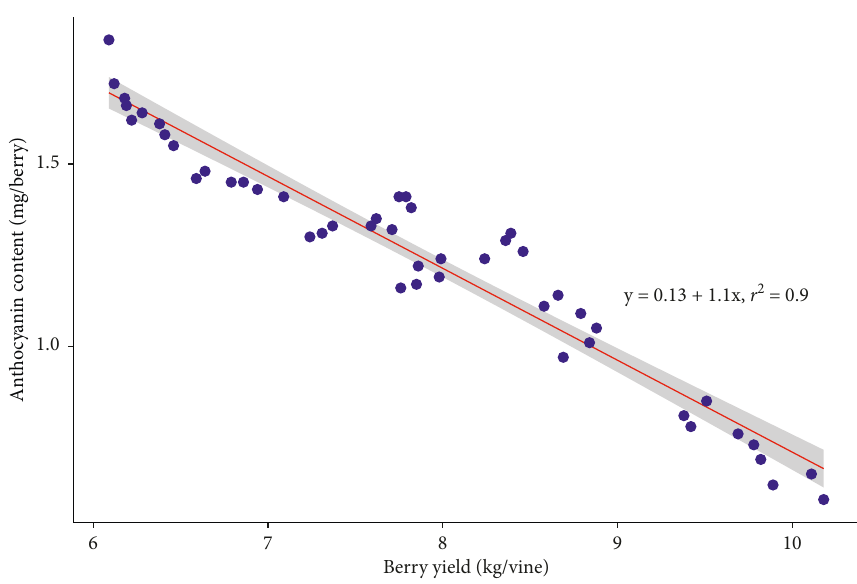
Figure 7: Correlation between grapevine berry yield and anthocyanin